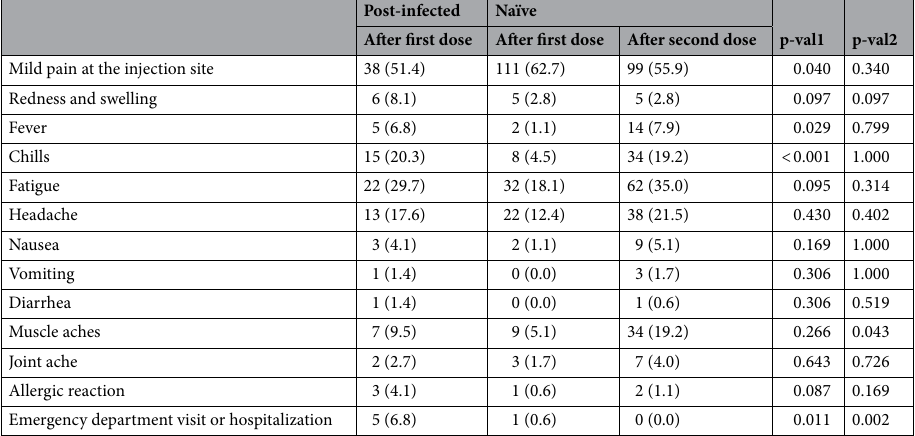
Post-infected Naïve